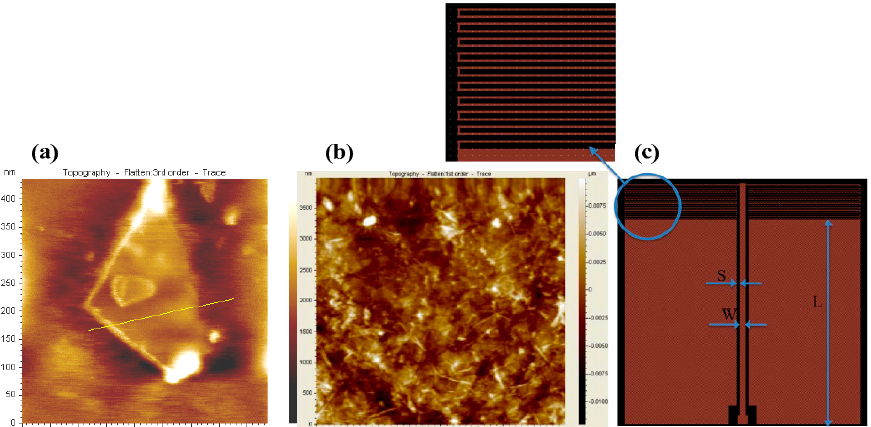
Figure 6. RF/microwave biosensor based on coplanar waveguide (CPW) line with meander resonator: atomic force microscope (AFM) image of GO flake ( a ) diluted 1:100 ratio; ( b ) concentrated samples; ( c ) CPW line with meander resonator, where L and W are the width and the length of the signal line, respectively and S is the spacing between the signal line and ground (reprinted with permission from [87]).